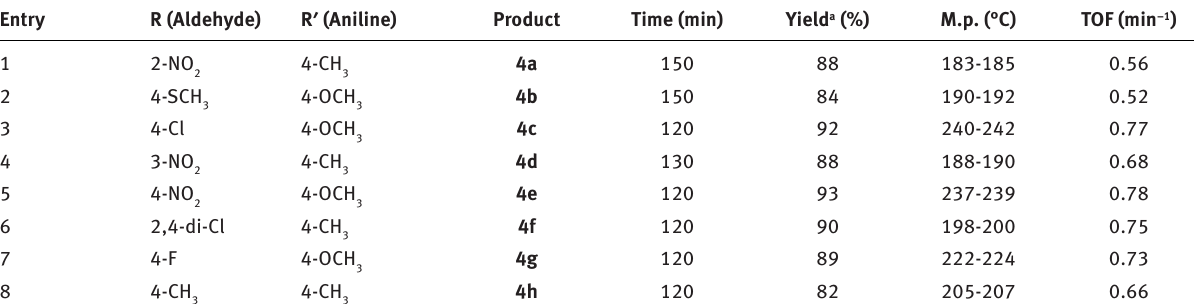
O @SiO -L-proline (8 mg) under reflux condition. 3 4 2